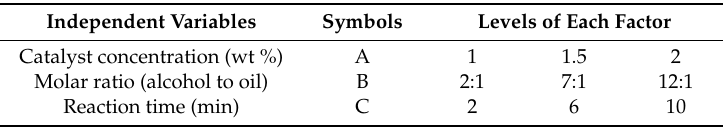
Table 2. Range of ANVOA.